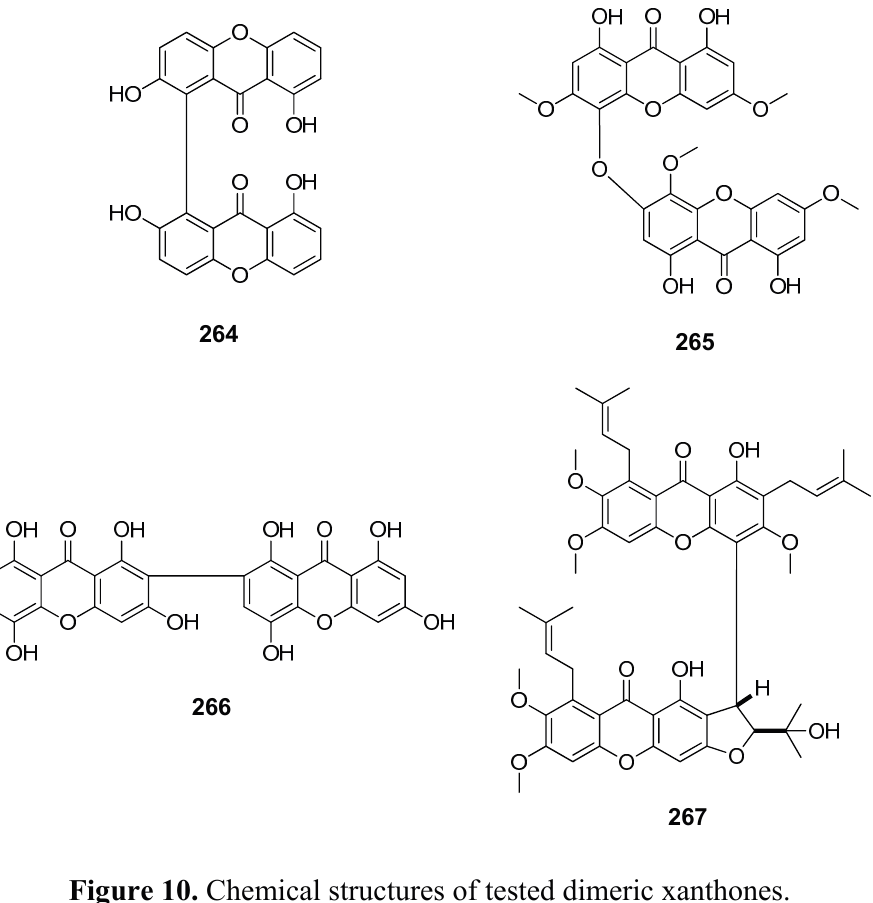
Figure 10. Chemical structures of tested dimeric xanthones.